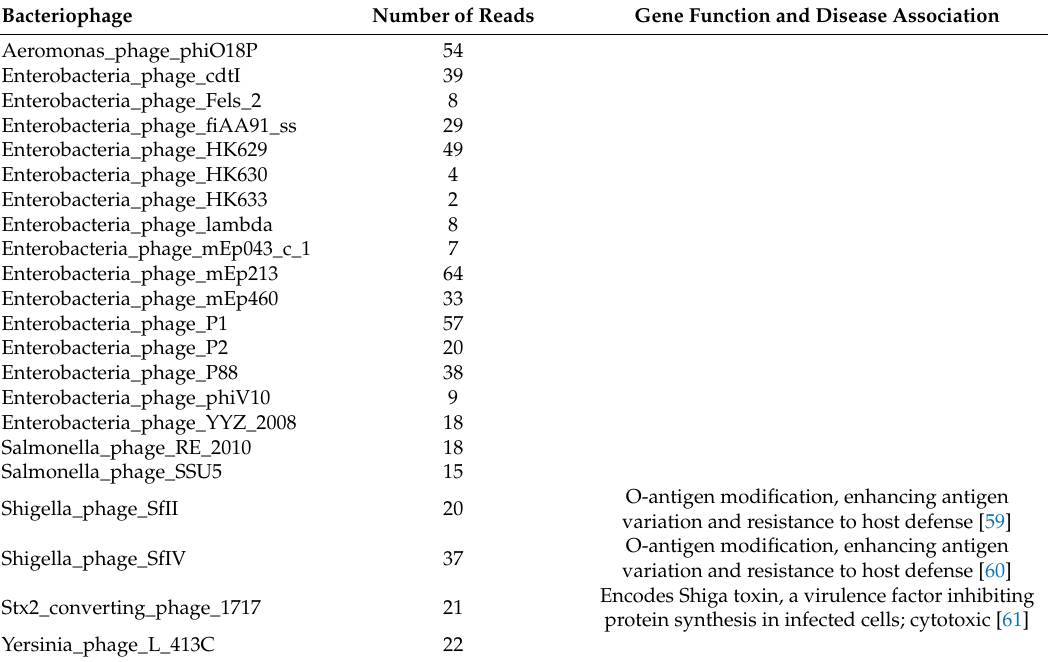
Figure 2. Krona plot of bacteria identified by metagenomic analysis of DNA prepared after selective growth on m-ColiBlue24 medium. Table 5. Bacteriophages detected in the metagenomic analysis of DNA from filtered water sample after growth on selective m-ColiBlue24 medium.